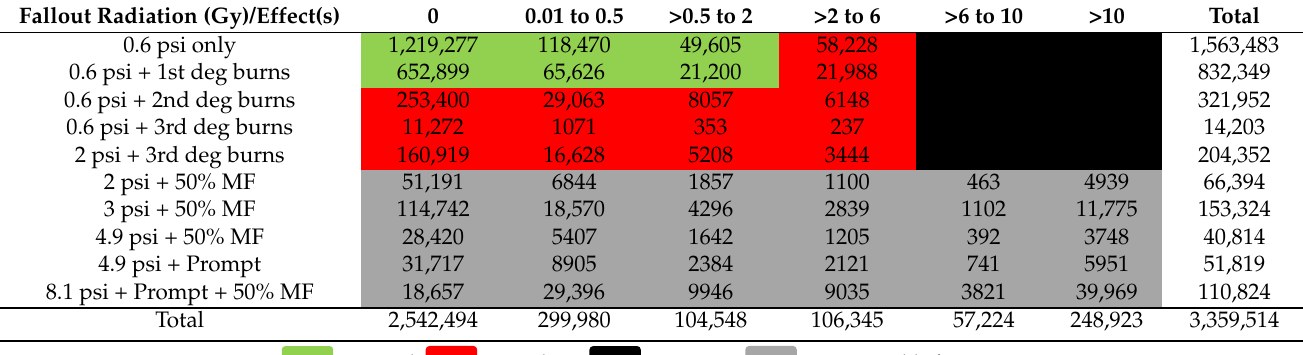
Table 4. Human casualties due to combined injuries (1 × 25 kt nuclear weapon).